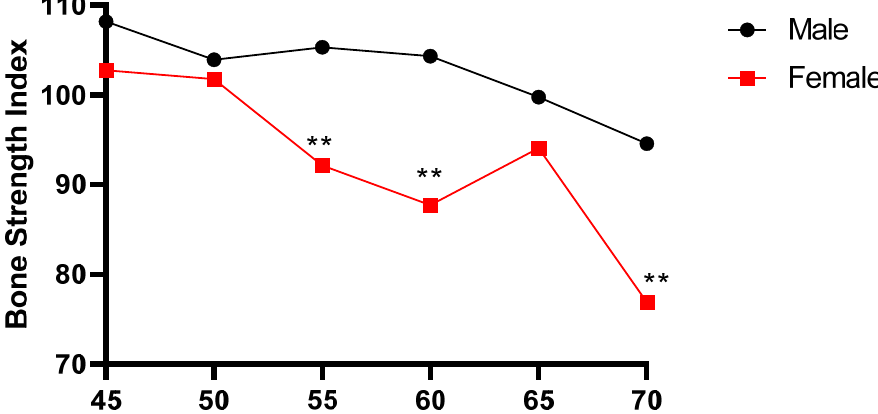
Figure 1. Trends of bone SI with age in middle-aged and elderly Mulam people. (male vs. female in the same age group, ** p < 0.01).